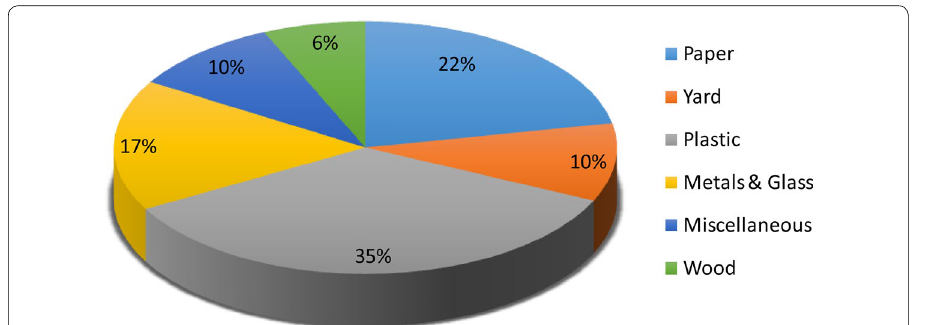
Fig. 3 MSW composition of Mavallipura landfill